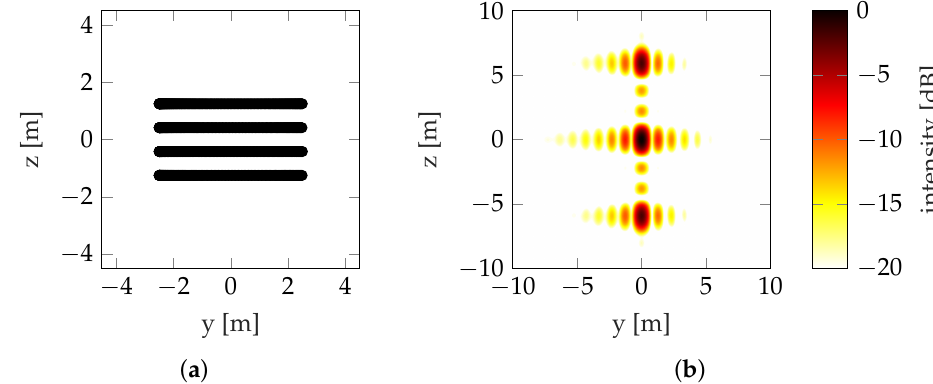
Figure 21. Reference scenario with four passes: ( a ) Trajectory. ( b ) PSF.